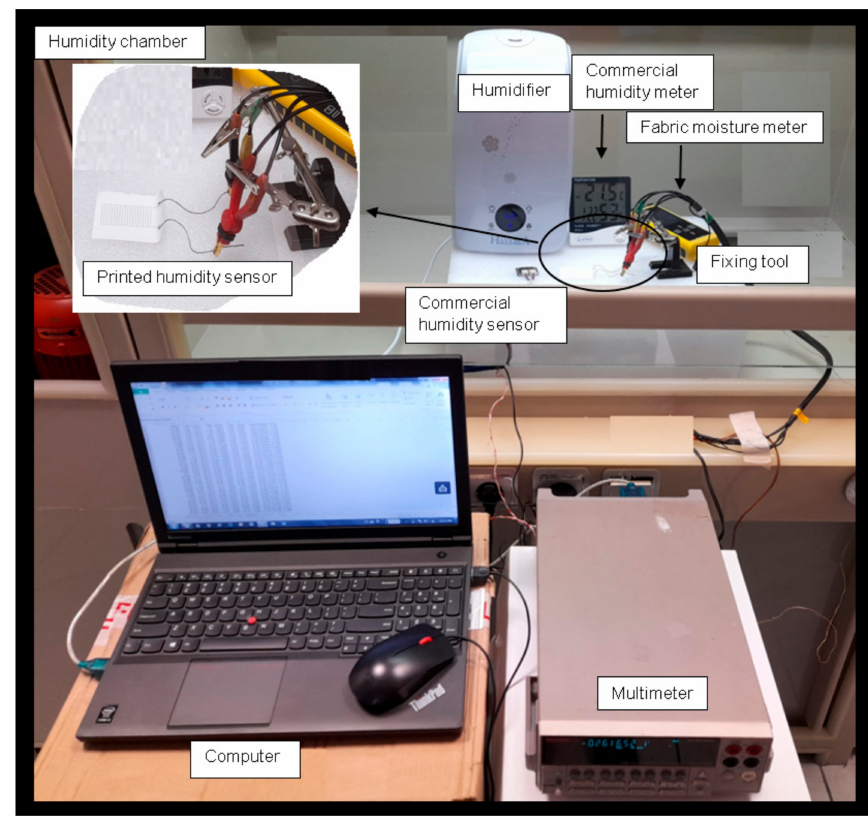
Figure 4. Humidity